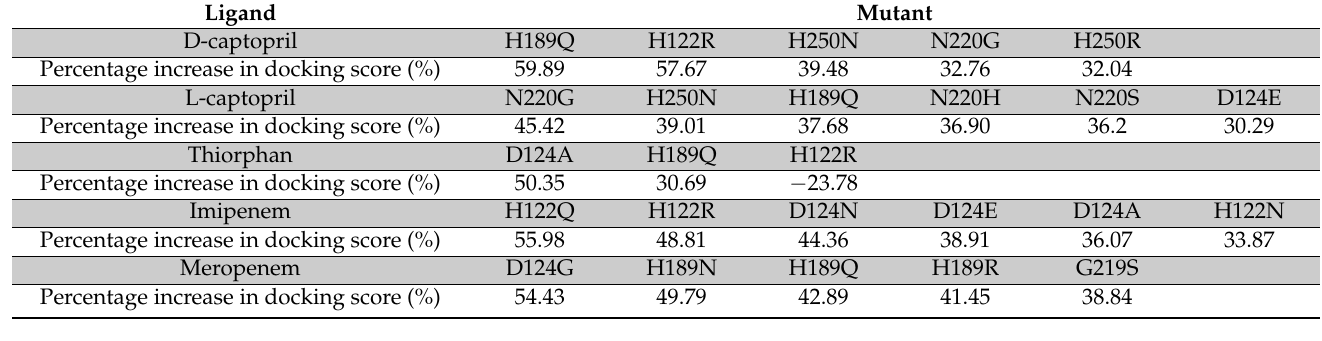
Table 3. Mutants with a high percentage increase in docking score in the ligand binding assay.